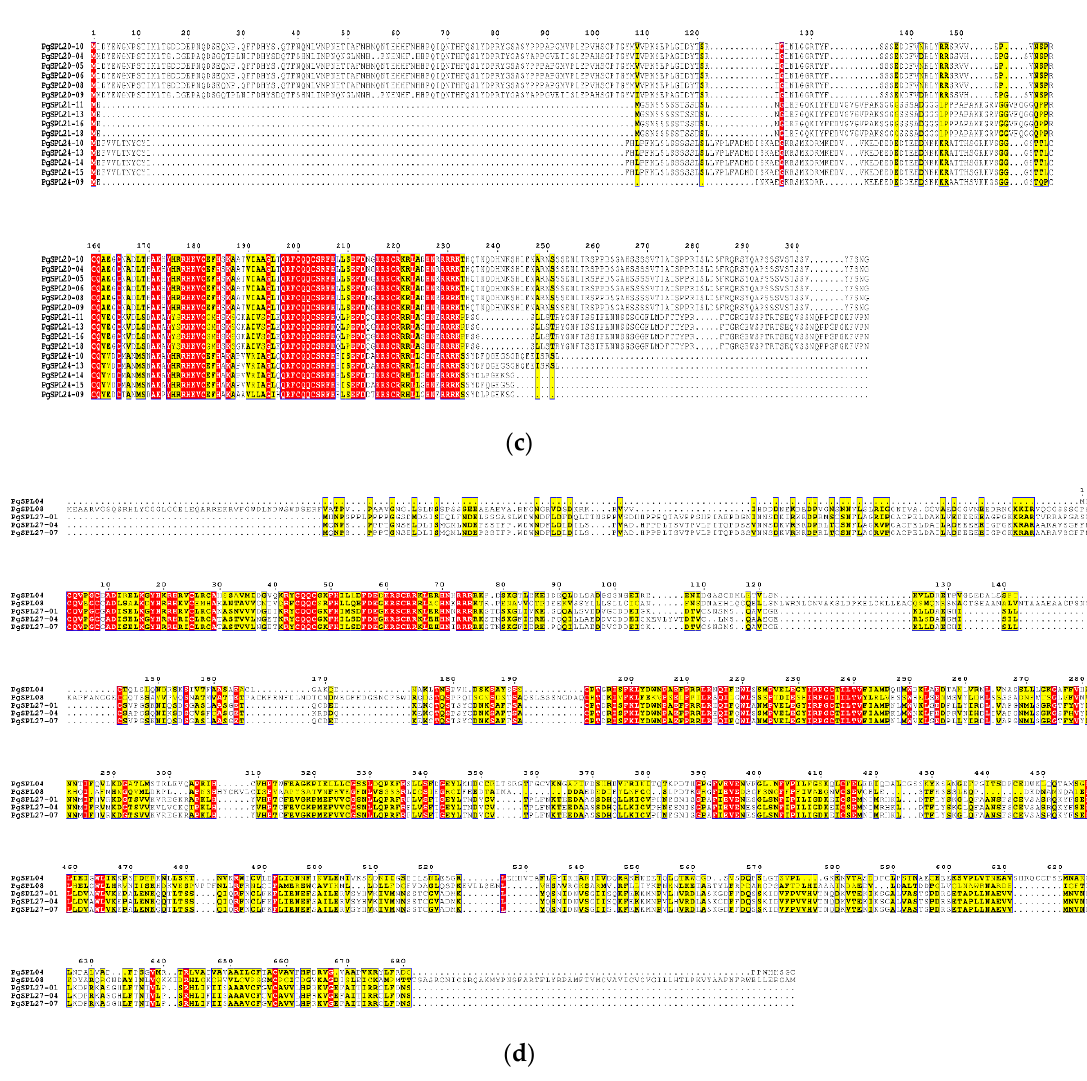
Figure 4. Multiple sequence alignment of SBP domain of the PgSPL proteins in ginseng. ( a ) Alignment of SBP domain of A1 group. ( b ) Alignment of SBP domain of A2 group. ( c ) Alignment of SBP domain of B1 group. ( d ) Alignment of SBP domain of B2 group.